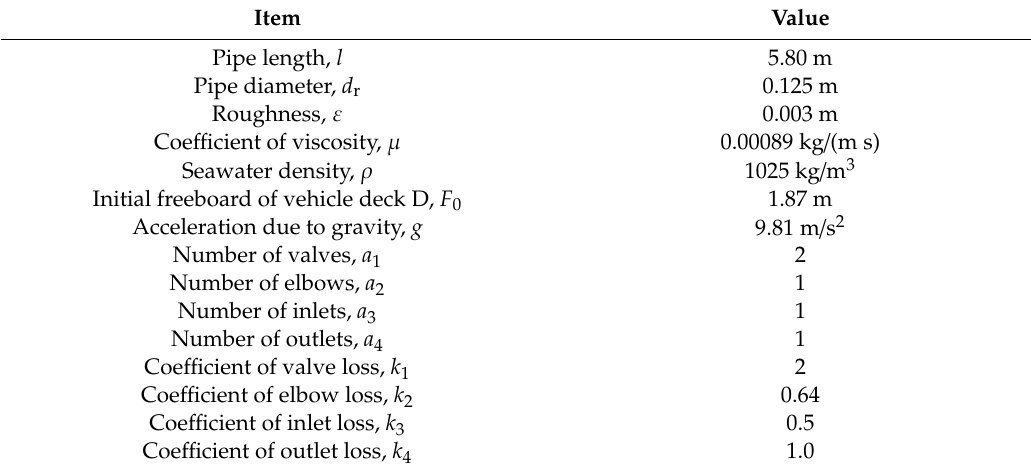
Table 2. The particulars of the scuppers on vehicle deck D of the M / V